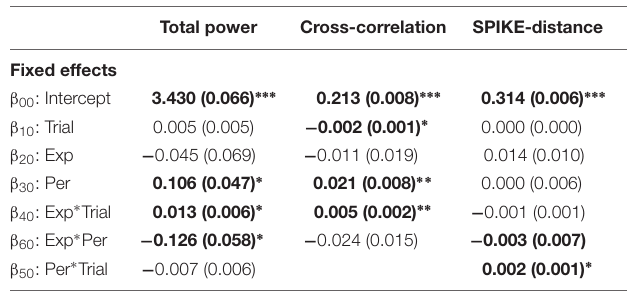
TABLE 1 | Linear mixed-effects modeling (LMEM) for total power, cross-correlation and spikes